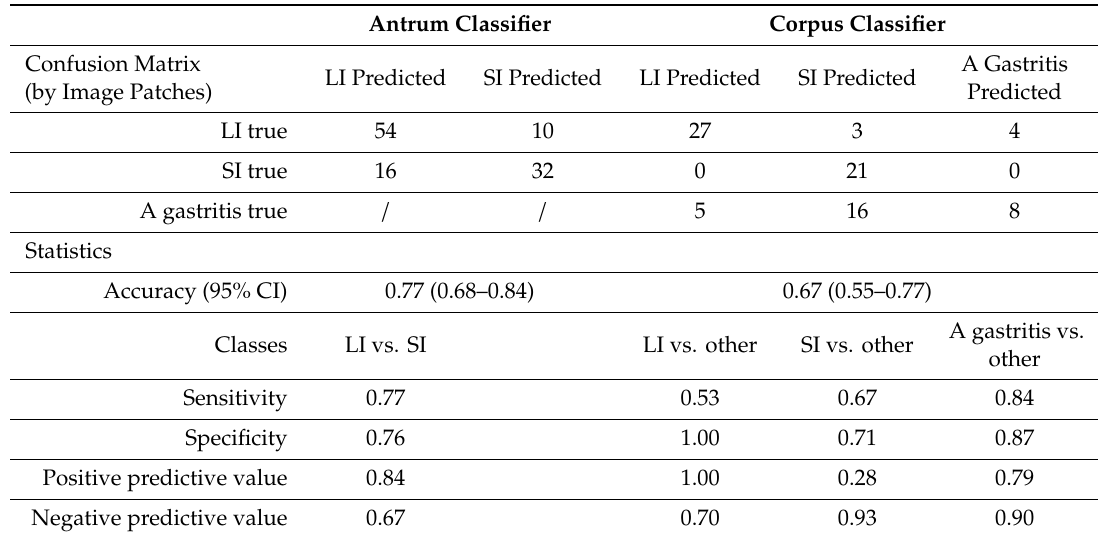
Table 2. Antrum and corpus classifier confusion matrix and statistics for the validation image patch set. Antrum Classifier